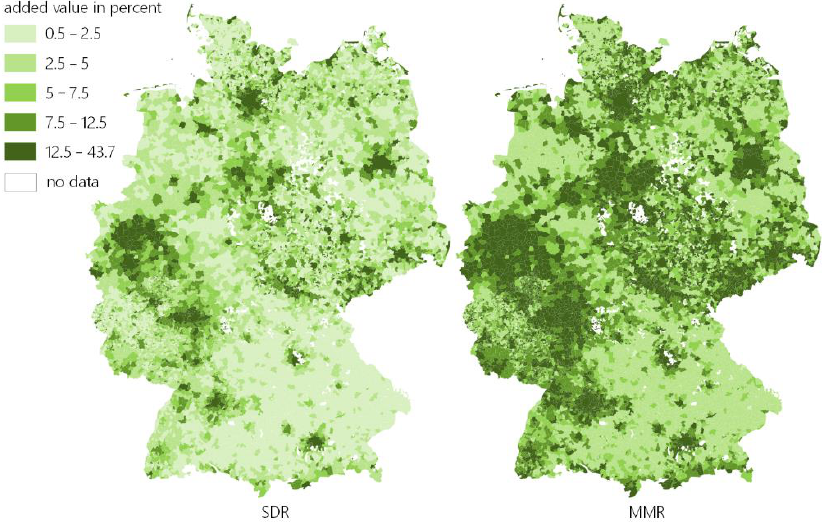
Figure 20. Regional disparities in added value from leveraging P2P sell prices versus selling at the market.